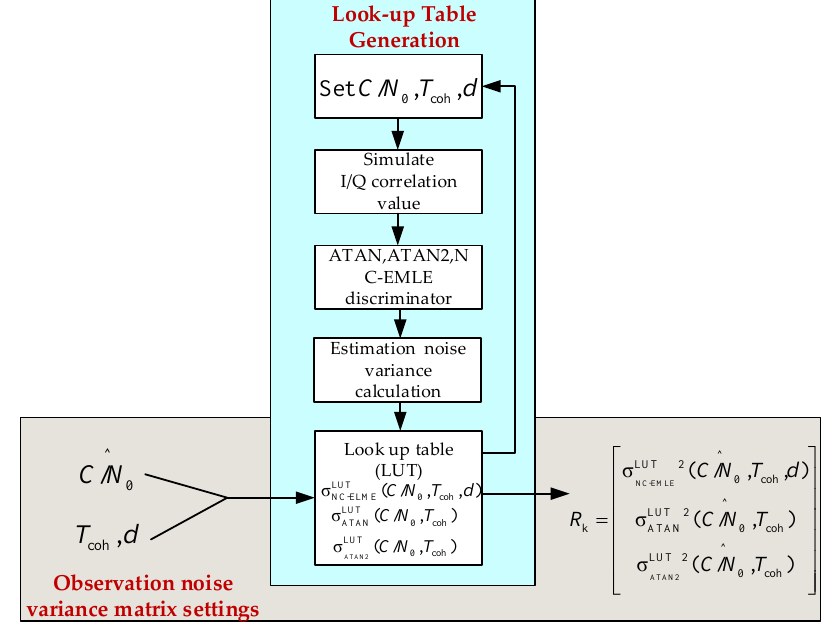
Figure 9. The generation and usage of look-up table.